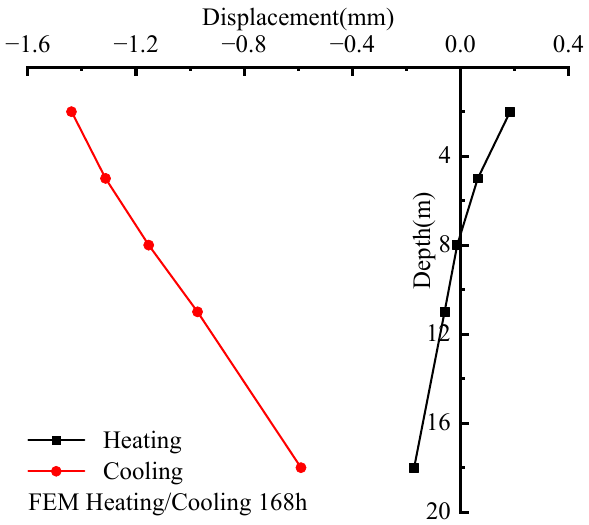
Figure 10. The variation curve of pile displacement with depth.